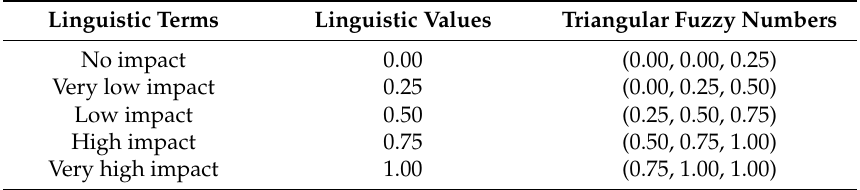
Table 2. Correlation on fuzzified Likert measure in place of measuring the criteria’